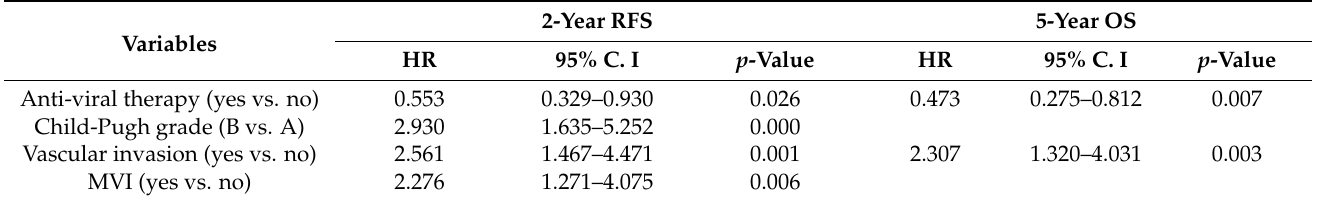
Table 3. Multivariate analyses of prognostic factors for 2-year RFS and 5-year